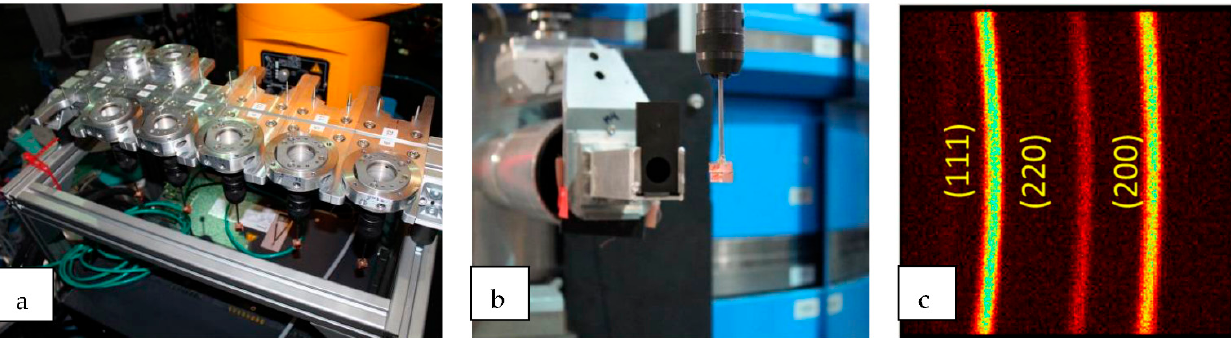
Figure 4. Phosphorus deoxidized copper tube (Cu DHP): ( a ) installed in the sample changer magazine; ( b ) mounted on the robot arm for pole figure measurement; ( c ) detector image at one position.